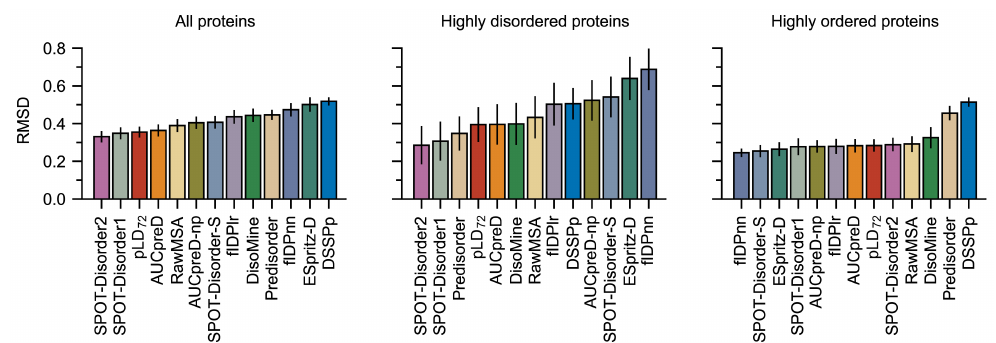
Figure 2. Average RMSD (Equation (2)) values calculated for the DisProt-PDB datasets using various prediction methods calculated per protein. Proteins were assigned to classes (highly disordered i.e., > 90% disorder and highly ordered i.e., < 10% disorder) based on datasets. Bootstrapping—that is, sampling with replacement—was used to compute averages and estimate errors with 10,000 samples of size 60. pLD 72 resulted in lower RMSD values on the DisProt-PDB dataset compared to DSSPp. pLDDT is abbreviated as pLD for plotting